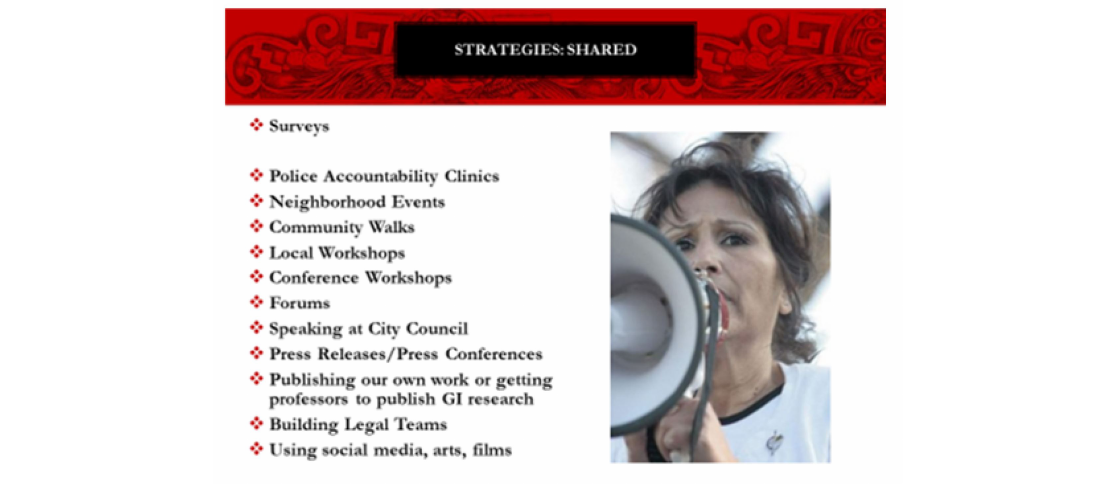
Figure 9. Slide #27 from Gabriela Hernandez’s PowerPoint ‘The Fight against Gang Injunctions’ (2021), an evolving document that has been presented many times as an organising